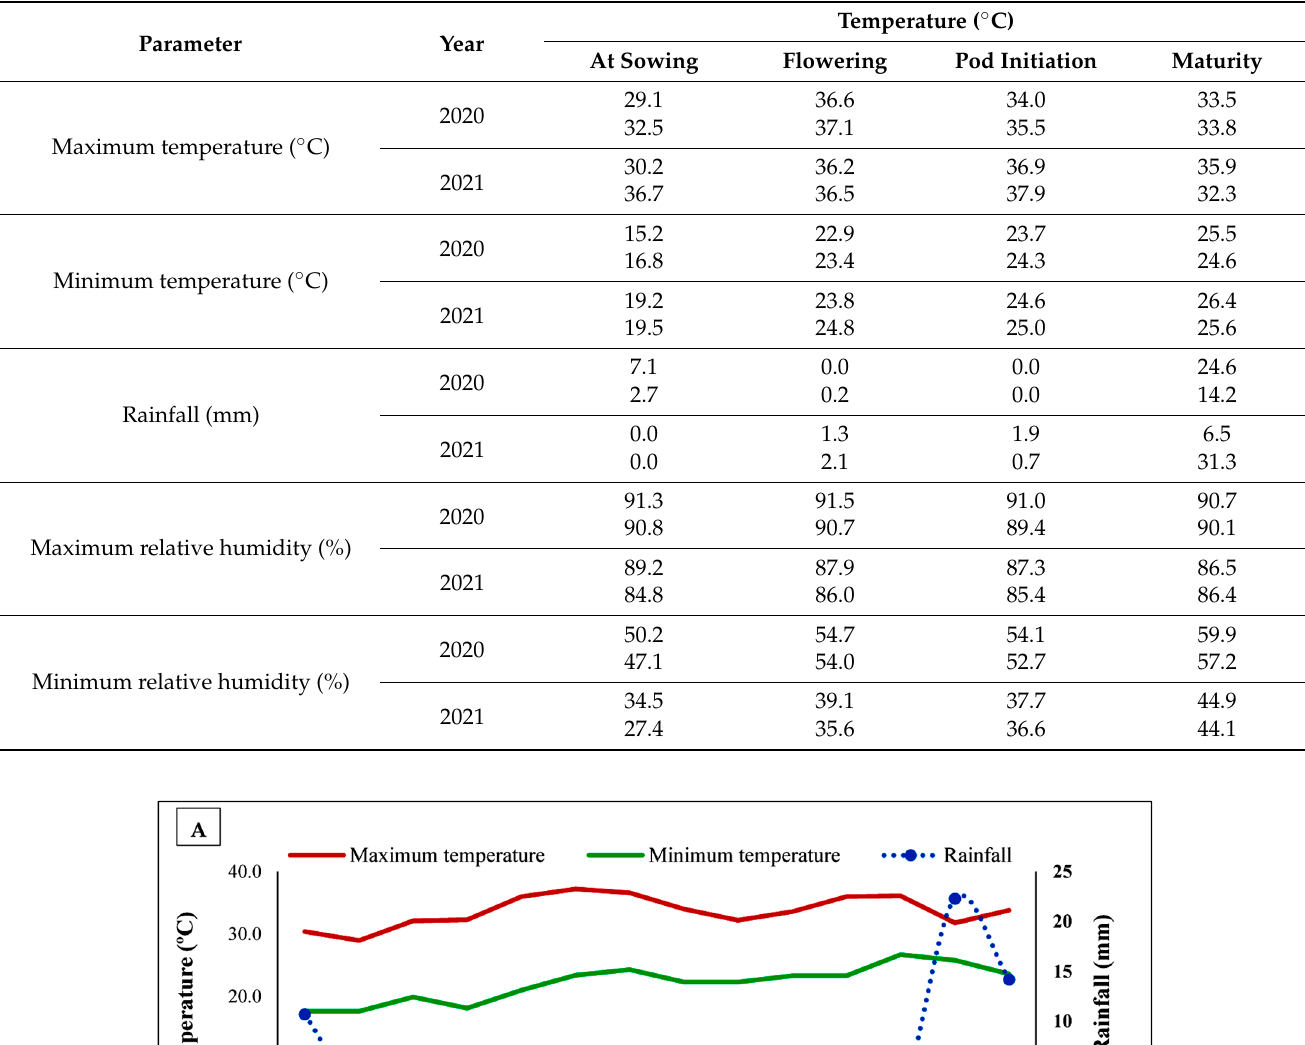
Table 1. Stage-wise mean maximum and minimum temperature and rainfall during black gram growing period.